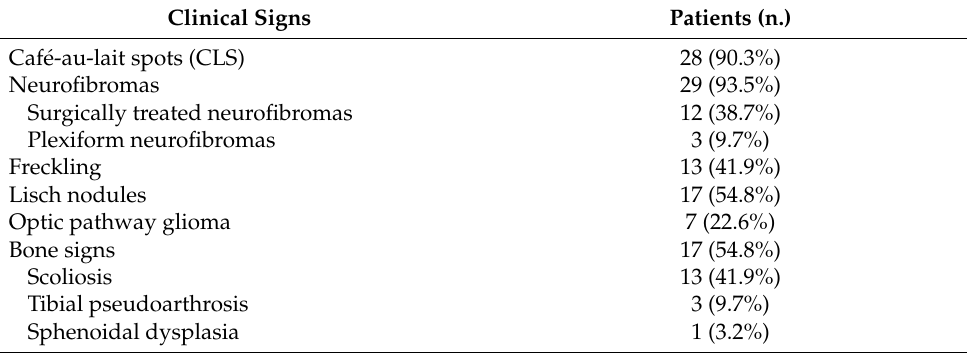
Table 2. Clinical signs of affected population.